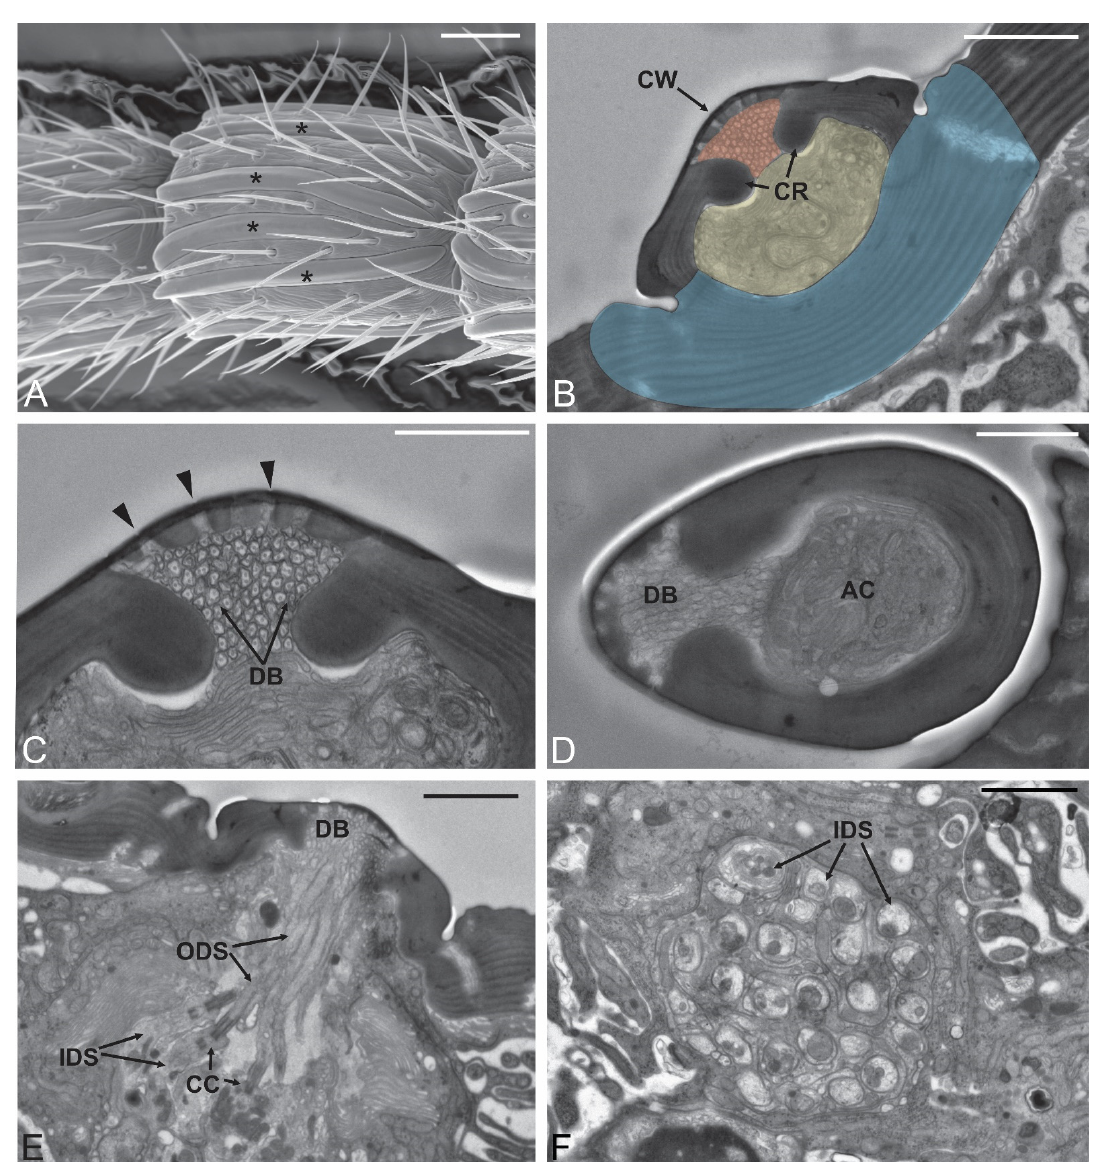
Figure 2. Sensilla placoidea. ( A ) SEM micrograph showing A9 with the presence of numerous sensilla placoidea (*): they can be as long as the antennomere itself. ( B – E ) Transmission electron microscopy (TEM) micrographs showing internal features of sensilla placoidea though sections taken at different levels. In ( B ), the sensillum is proximal to its distal end. Different regions were colored to better highlight the different areas. In red is the area occupied by the dendritic branches projected by the outer dendritic segments innervating the sensillum. They completely fill the lumen that is externally outlined by the sensillum cuticular wall (CW), while internally there are two cuticular ridges (CR). Just below these two elements, there is a second area (colored in yellow) that is occupied by the sensillum accessory cells, and at this level is separated from the antennal lumen by a thick cuticular wall (colored in blue). More distally ( D ) the sensillum is separated from the antennal wall but still maintains the separation into two regions. In ( C ), the cuticular pores (black arrowheads) that open on the sensillum wall are presented. ( E ) TEM proximal cross-section showing the sensory neurons innervating the sensillum placoideum. Each sensory neuron is clearly divided into a proximal inner dendritic segment (IDS) and an outer dendritic segment (ODS). Between them, typical ciliary constrictions (CC) are visible. ODS enter the sensillum lumen where they organize in numerous dendritic branches (DB). Each sensillum placoideum is innervated by about 25 sensory neurons, as shown in ( F ). Bar scale: ( A ), 20 µ m; ( B , E , F ), 2 µ m; ( C , D ), 1 µ